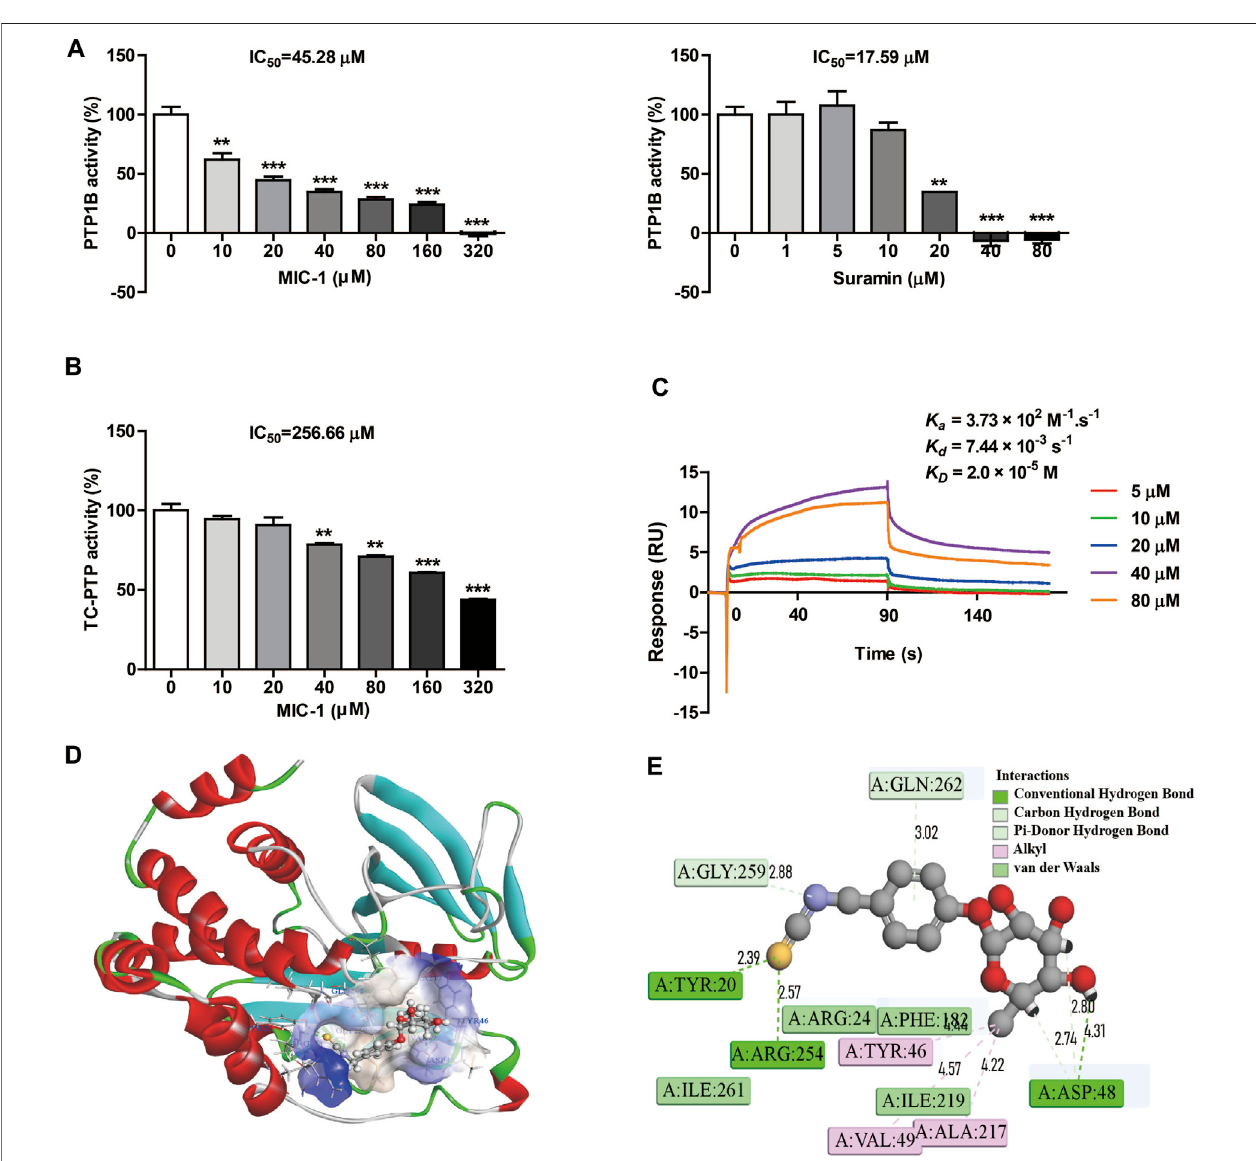
FIGURE 4 | MIC-1 selectively inhibits PTP1B activity. (A) The inhibitory activities of MIC-1 and suramin against PTP1B. (B) The inhibitory activity of MIC-1 against TC-PTP. (C) MIC-1directly binds toPTP1B withhigh af fi nity (KD (cid:1) 2.0 × 10 − 5 M).Biolayerinterferometry (BLI)sensorgrams indicating theinteractionsbetween gradient concentrationsofMIC-1andPTP1BweremeasuredonanOctetRed96system,withassociationanddissociationfor90 seach. (D) Three-dimensionalsimulationofthe interaction between MIC-1and the PTP1B protein. (E) Two-dimensional simulationofthe interaction between MIC-1 and the PTP1B protein. Values represent the means ± SEM from three independent experiments and statistical analysis was performed by one-way ANOVA; ** p < 0.01, *** p < 0.001: MIC-1 compared with the control (0 μ M).